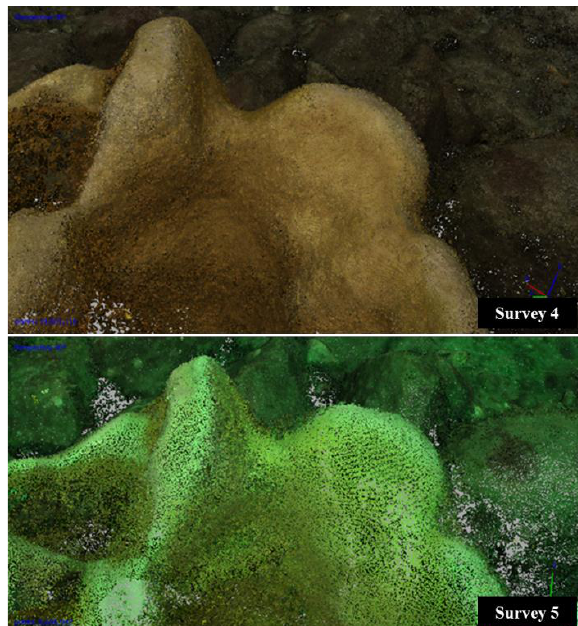
Figure 8. The photographs from Survey 4 (Top) produced a higher density point cloud than the extracted images from Survey 5 (Bottom).